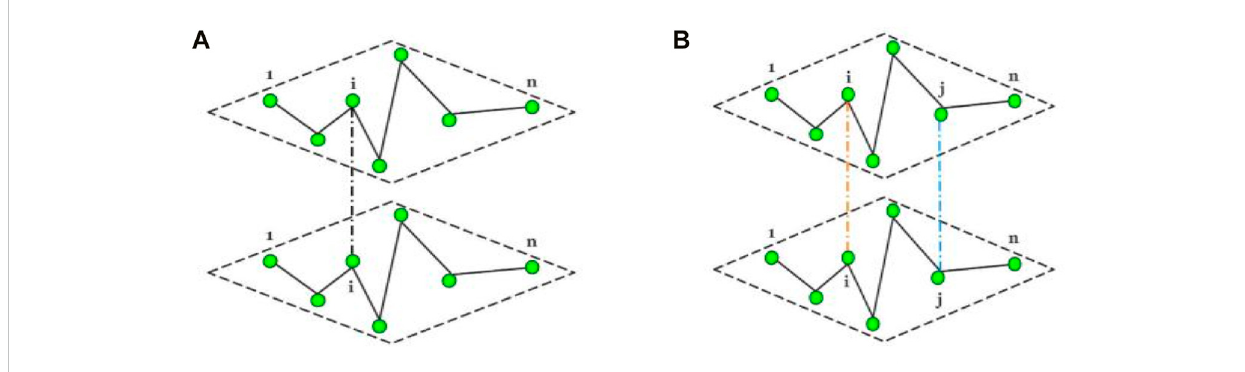
FIGURE 1 (A) Schematic diagram of a double-layer chain network G s . (B) Schematic diagram of a double-layer chain network G d